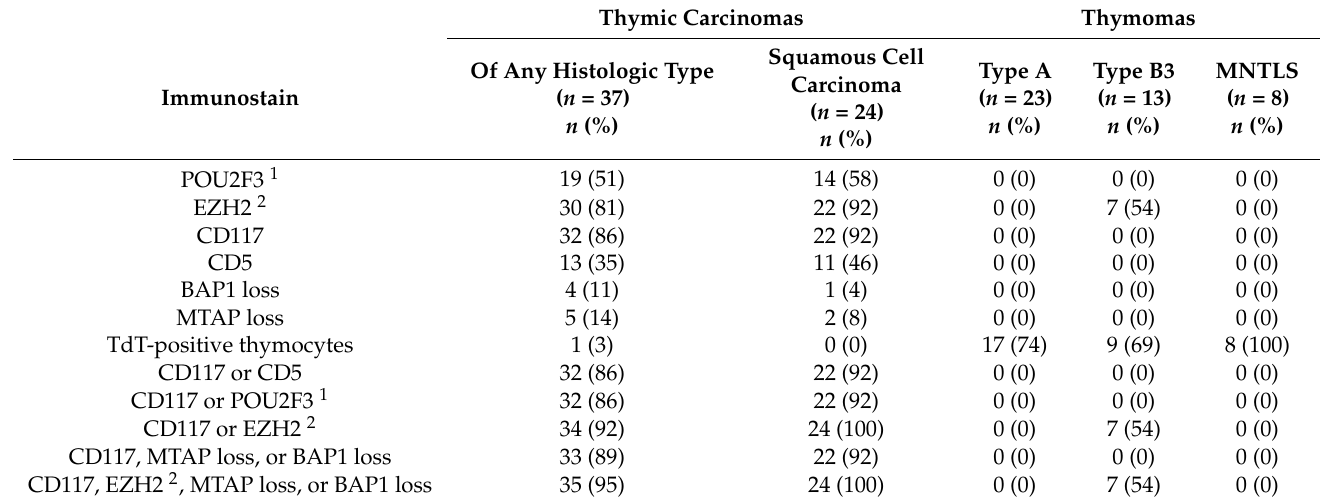
Table 3. Proportion of cases with positive staining for single or combined